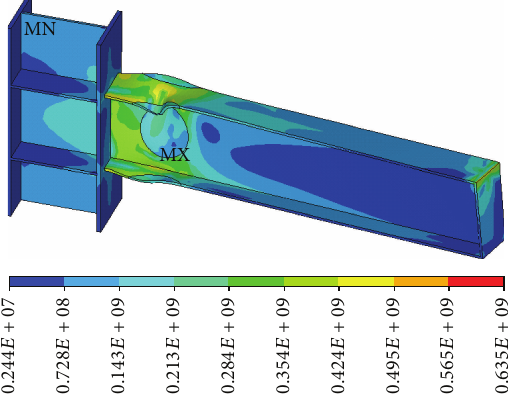
Figure 9: Stress of replaceable connection